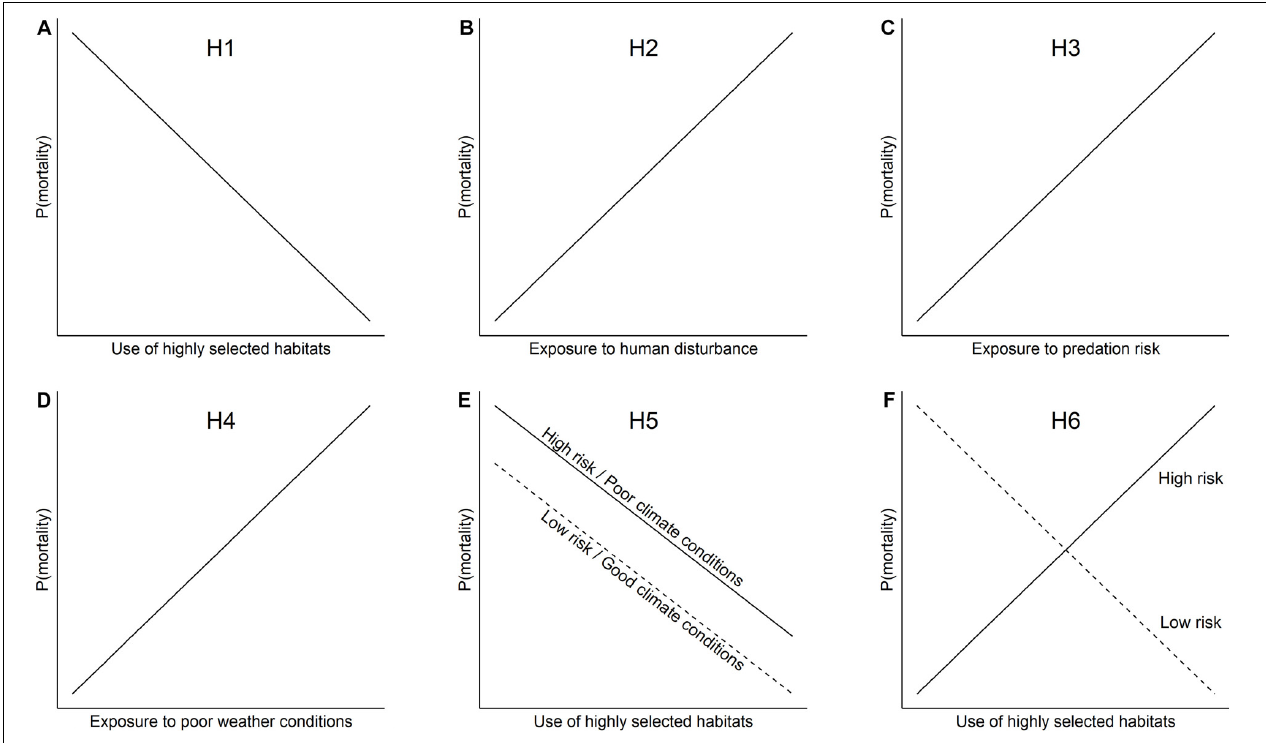
FIGURE 1 | Hypotheses and predictions tested to explain variations in the risk of mortality of eastern migratory caribou of the Rivière-aux-Feuilles (RFH) and Rivière-George herds (RGH), northern Québec and Labrador, Canada (2009–2016). Competing hypotheses H1 through H6 (as given in the text) included (A) the use of highly selected habitats (% of individual locations in highly selected habitats), (B) exposure to disturbance risk, (C) exposure to predation risk, (D) exposure to poor weather conditions, (E) additive effects, and (F) maladaptive habitat